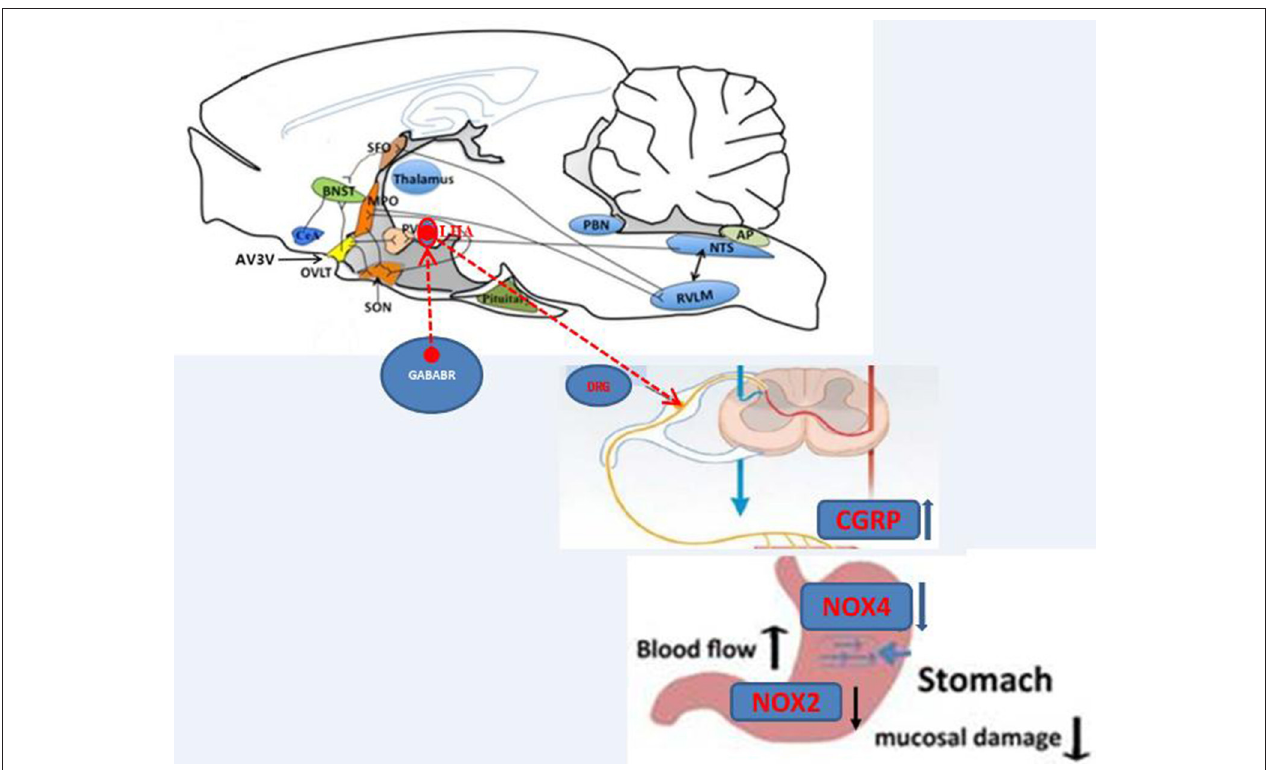
FIGURE 13 | Illustration of the effects of GABA B R in the LHA on GI-R